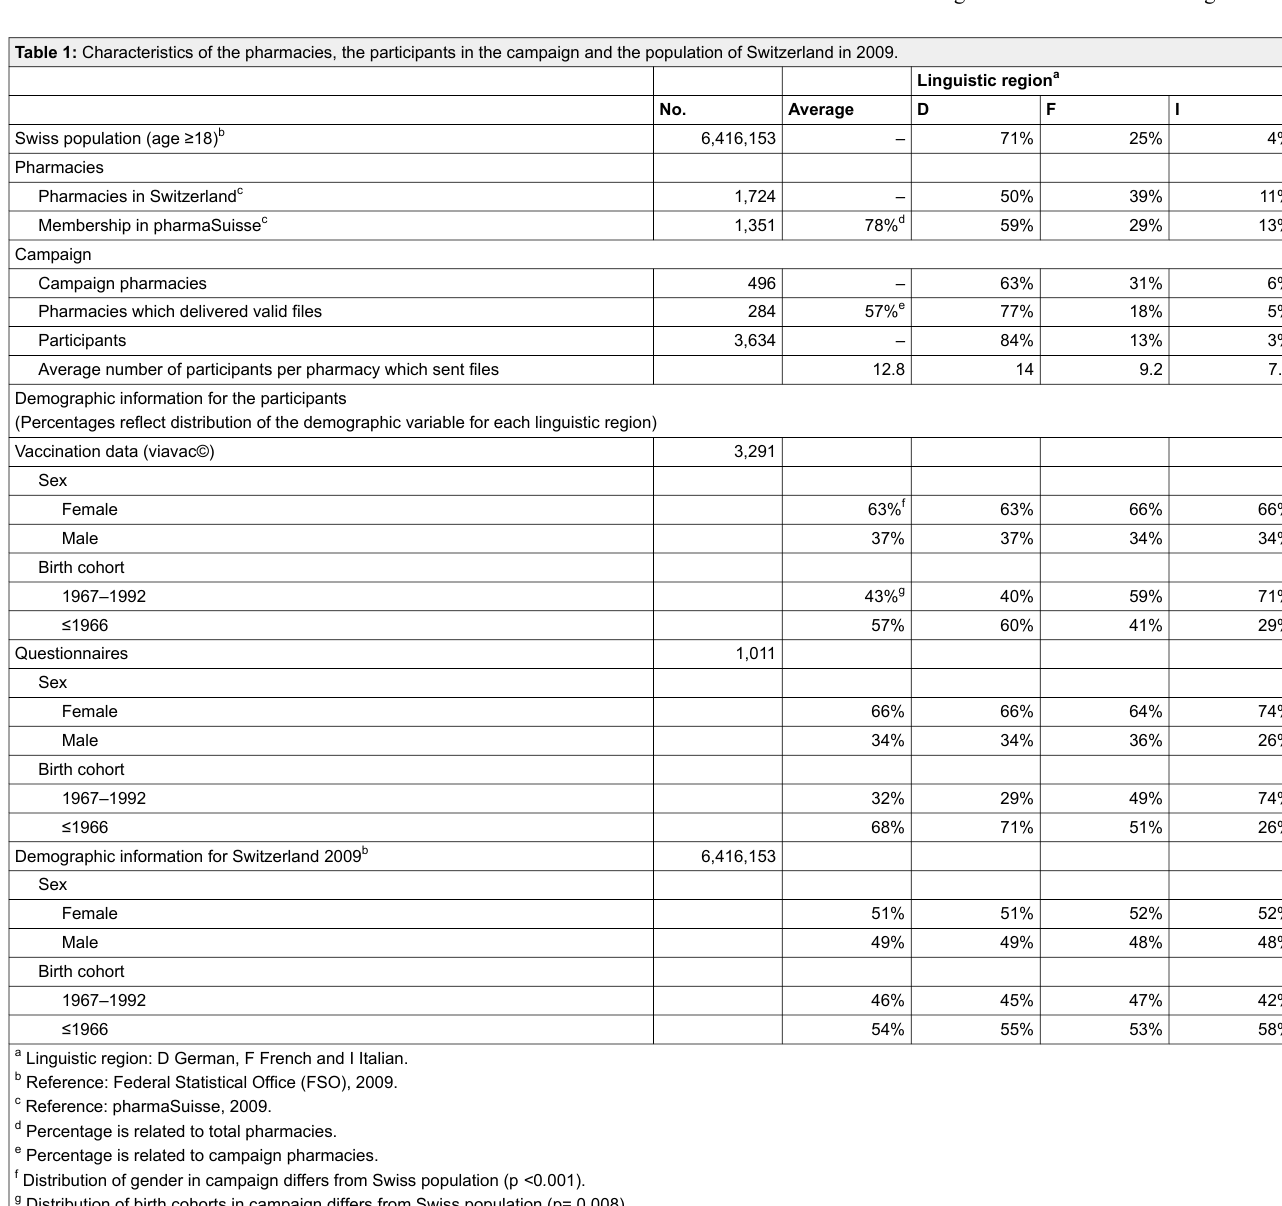
Table 1: Characteristics of the pharmacies, the participants in the campaign and the population of Switzerland in 2009.